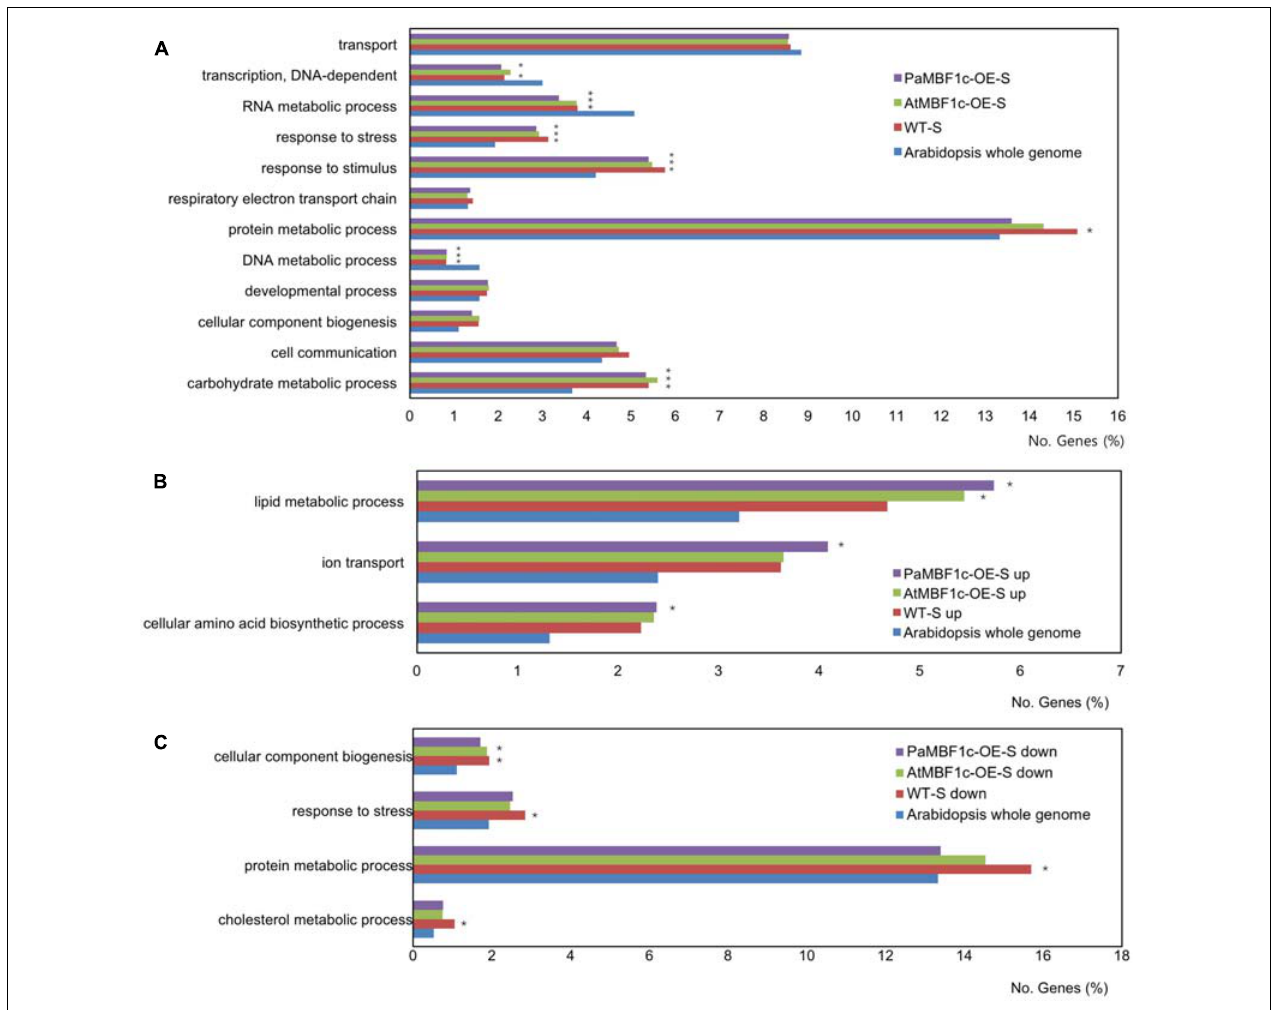
FIGURE 8 | Gene ontology enrichment analysis of salt regulated genes in WT, PaMBF1c -OE, and AtMBF1c -OE lines. (A) Gene Ontology (GO) terms with significance (corrected p -value of Bonferroni correction < 0.05) from the GO enrichment analysis with salt-regulated genes using Arabidopsis whole genome as a comparison reference. (B) Functional GO classification of genes salt up-regulated genes based on plant GO slim terms. (C) Functional GO classification of genes salt down-regulated genes based on plant GO slim terms. Only GO terms with significance (corrected p -value of Bonferroni correction < 0.05) from the GO enrichment analysis were presented. For suffix of each line in the graph legends, “-S” indicates “salt-treated,” “up” and “down” mean “up-regulated” and “down-regulated,” respectively. Asterisks indicate statistical